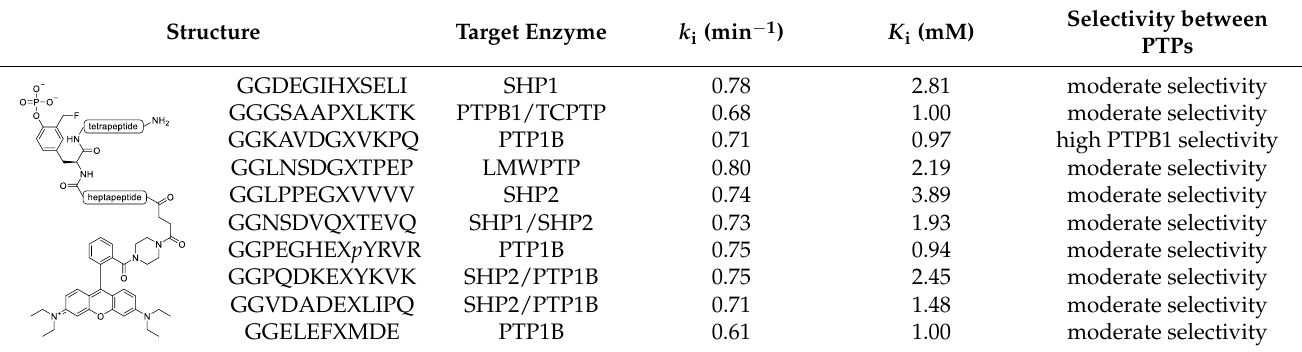
Table 1. Kinetic data of the enzyme inhibition of probes from [34].